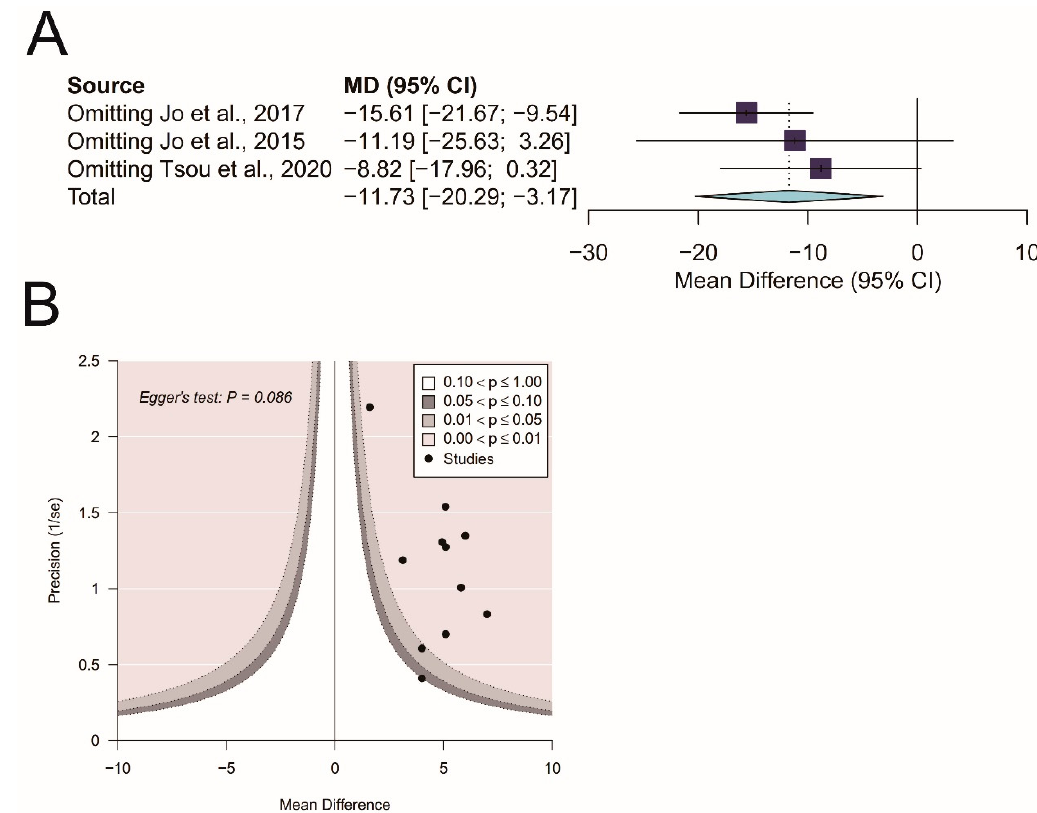
Figure 12. ( A ) Influence analysis of complete chest recoil; ( B ) contour-enhanced funnel plot of chest-compression depth (Egger’s test for asymmetry: p = 0.086).